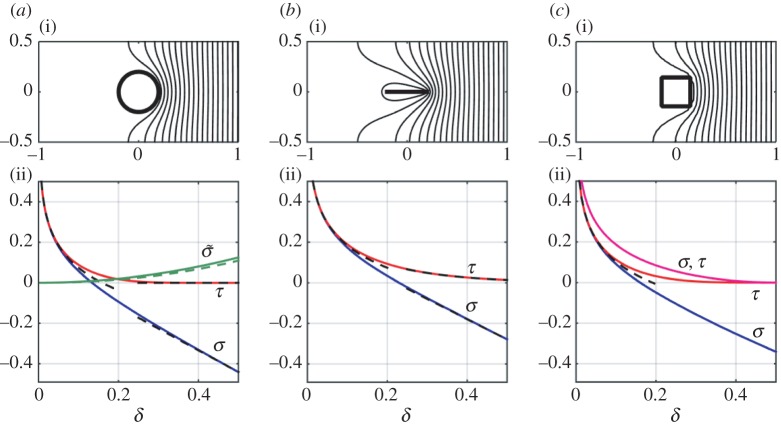
Solutions to the Dirichlet cell problem (3.8)–(3.11) for (a) disc-shaped wires with radius δ, (b) infinitely thin perpendicular line segments with length 2δ, and (c) square wires with side length 2δ. Panels (a(i),b(i),c(i)) show contours of Φ+(N,S) for δ=0.2. Panels (a(ii),b(ii),c(ii)) show the constants σ and τ in the far field expansion, as a function of δ. Dashed lines show asymptotic behaviour of σ and τ as δ approaches 0 and 12 (or δ→∞ in (b) here the asymptotic and numerical curves are almost indistinguishable). In (a), the higher order correction σ~ from (A 13) is also shown, for Model 1 (solid) and Model 2 (dashed), and in (c) the upper magenta curve shows σ=τ for a tangential line segment of length 2δ, from (B 4). (Online version in colour.)